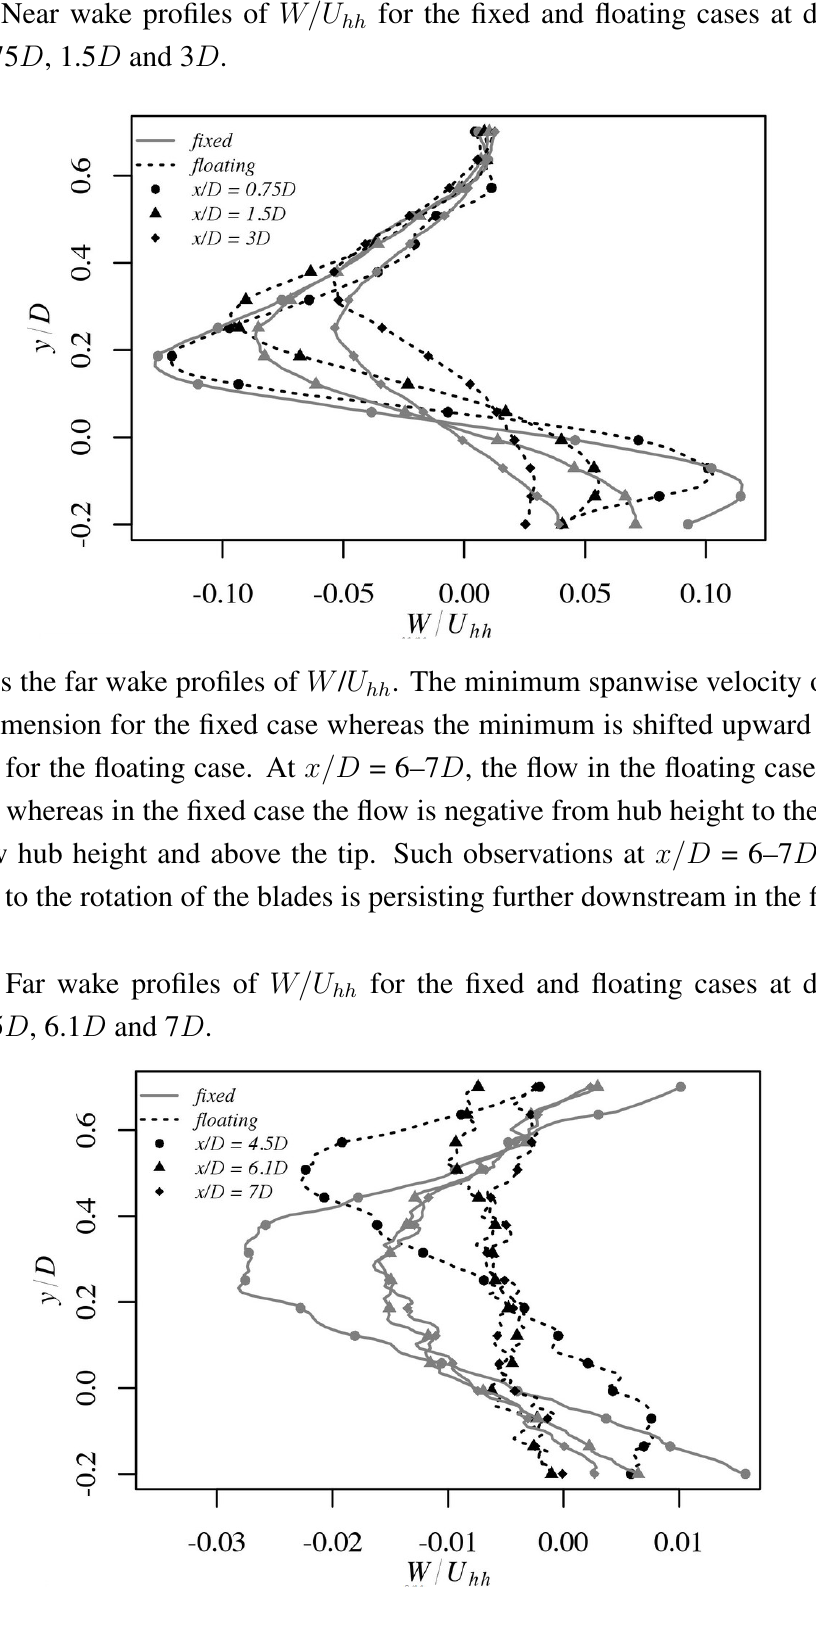
for the fixed and floating cases at downstream hh